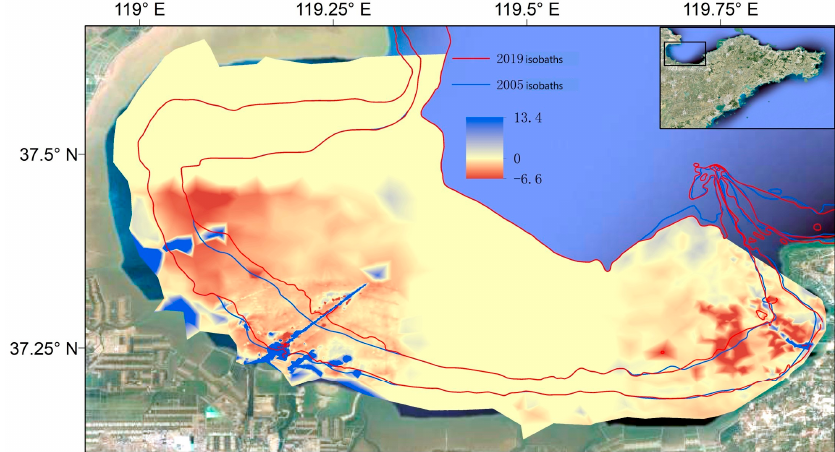
Figure 5. Isobath and scouring–siltation changes in Laizhou Bay.